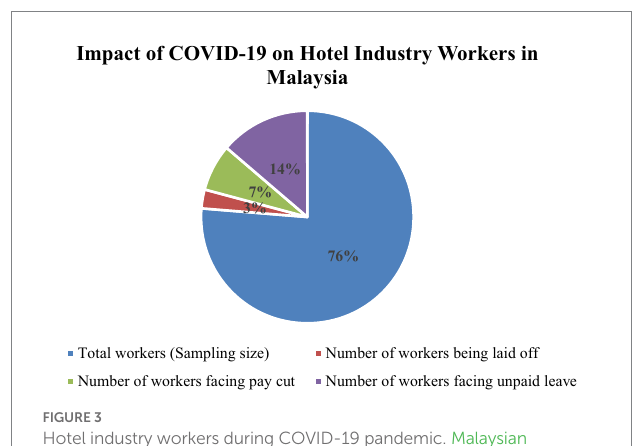
FIGURE 3 Hotel industry workers during COVID-19 pandemic. Malaysian Association of Hotels [MAH] (2020).